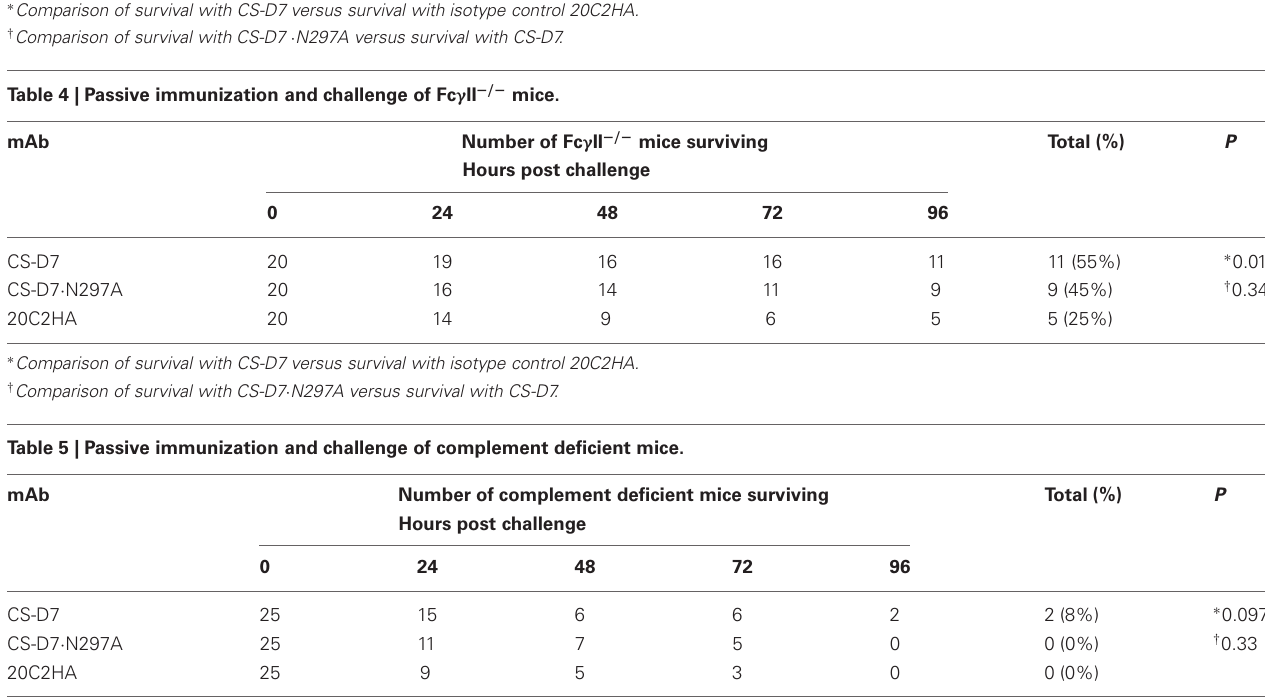
∗ Comparison of survival with CS-D7 versus survival with isotype control 20C2HA. † Comparison of survival with CS-D7 · N297A versus survival with